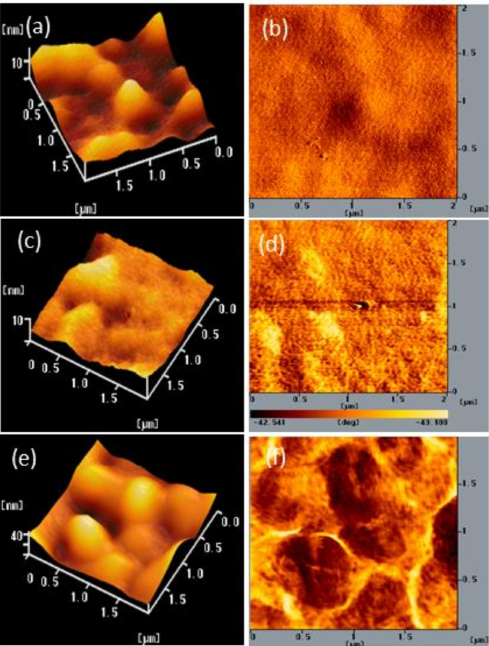
Figure 7. ( a , c , e ) Topographic and ( b , d , f ) phase AFM images of a BCP film after storage at 30 ◦ C and